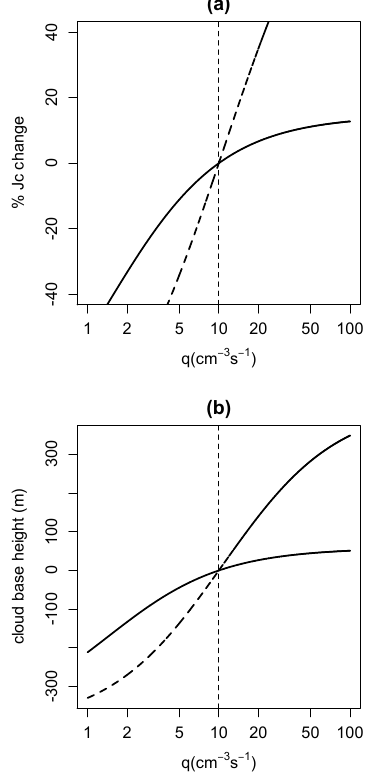
Fig. 2. Calculated response in atmospheric electric and cloud pa- rameters to changes in the surface air volumetric ion production rate q for low pollution air (solid lines) assuming 2000 particles cm − 3 of radius 0.25µm, and polluted air (dashed lines), assuming 15000 particles cm − 3 . Variations are shown for (a) the vertical conduction current J c and (b) changes in the observed cloud base